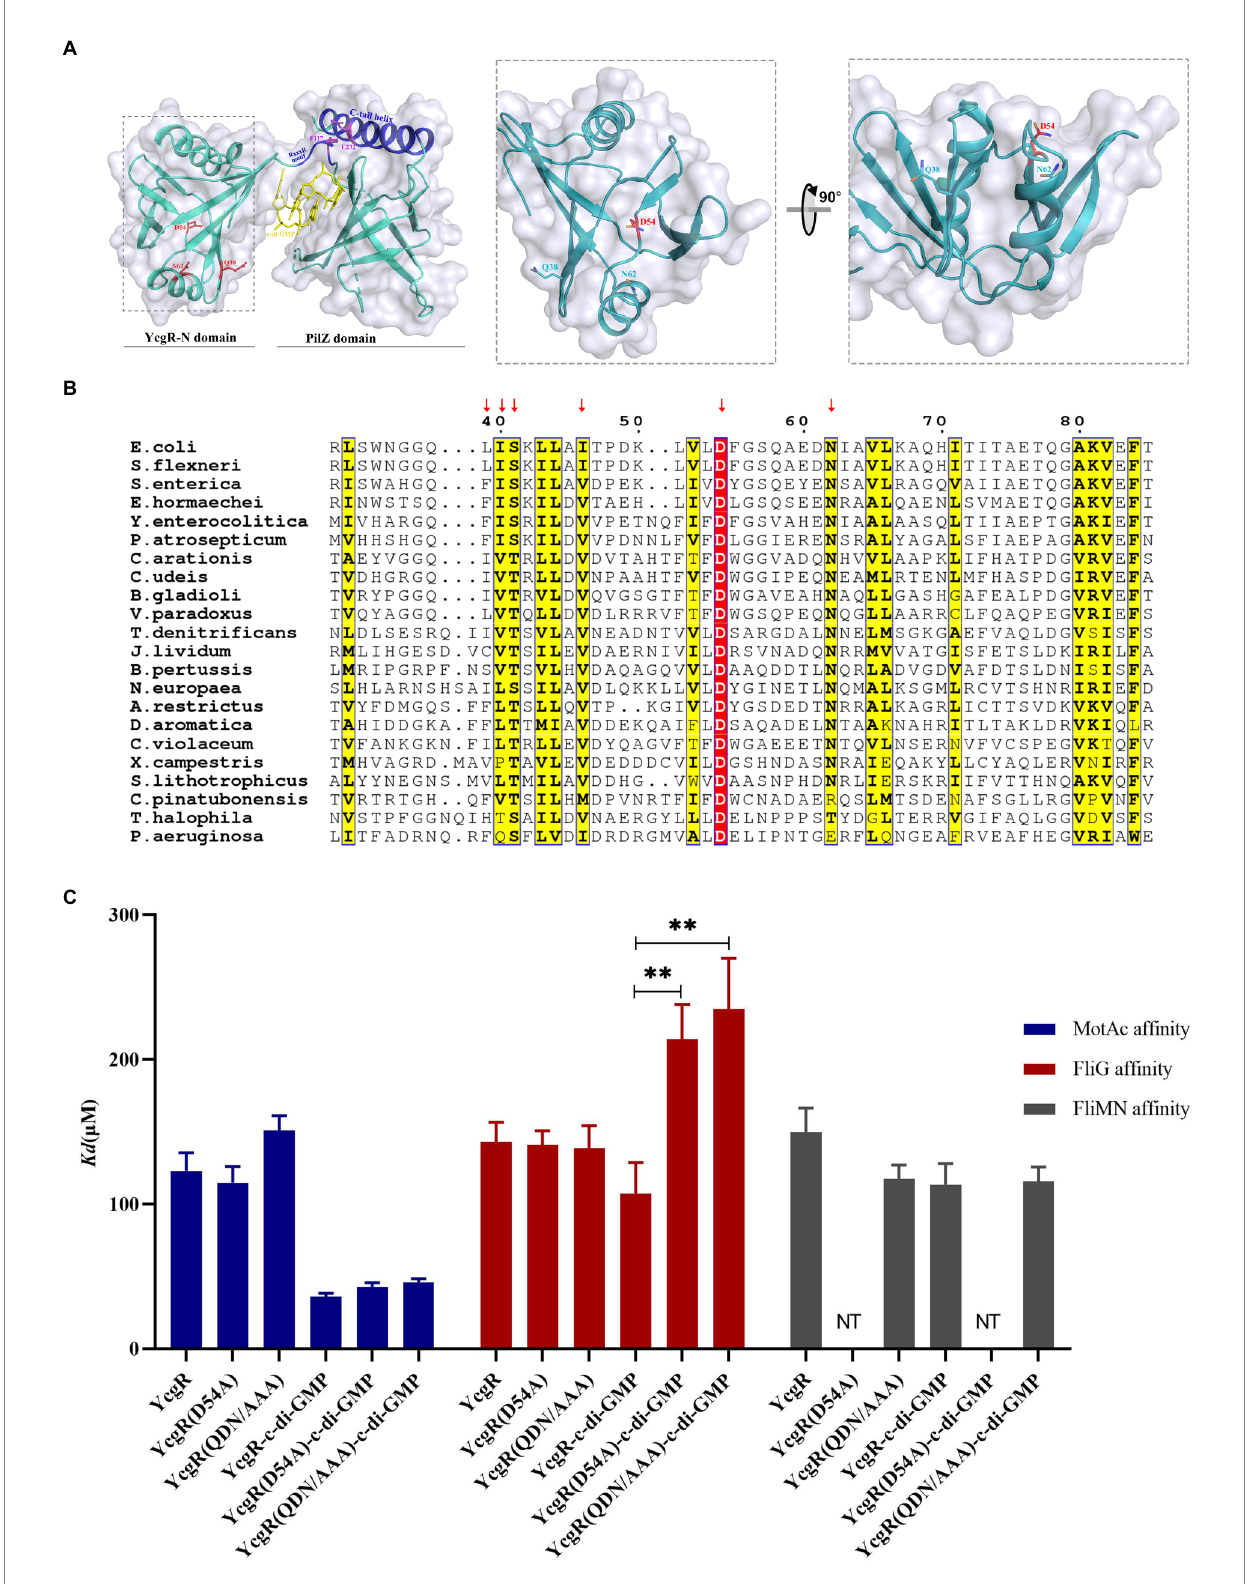
FIGURE 3 Residue D54 of YcgR was involved in FliG binding. (A) The structure of the YcgR protein (derived from PDB 5Y6G) comprised the PliZ domain and the YcgR-N domain. The panel in the dashed line box displayed the conserved residues in the YcgR-N domain. The previously identified MotA binding site was highlighted in blue. (B) Sequence alignment of YcgR and similarities from Escherichia coli and other 27 prokaryote species. The yellow columns indicated the conserved amino acid residues of YcgR and similarities, including Q38, N62, I40, and L44. The red column indicated residue D54 as the only identical amino acid among those YcgR similarities in the YcgR-N domain. (C) The histogram showed the dissociation constants between YcgR variants and motor proteins (MotAc in blue, FliG in red, FliMN in gray) with or without c-di-GMP. NT, not tested. The results were analyzed by statistics method t -tests (and nonparametric tests). Analysis of significant differences (Two-tailed):, p ≤ 0.01: